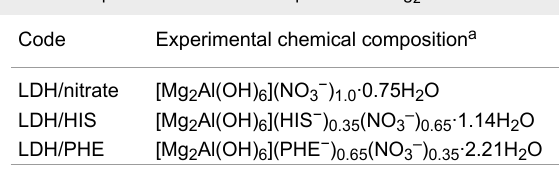
Table 1: Experimental chemical compositions of Mg 2 Al LDHs.